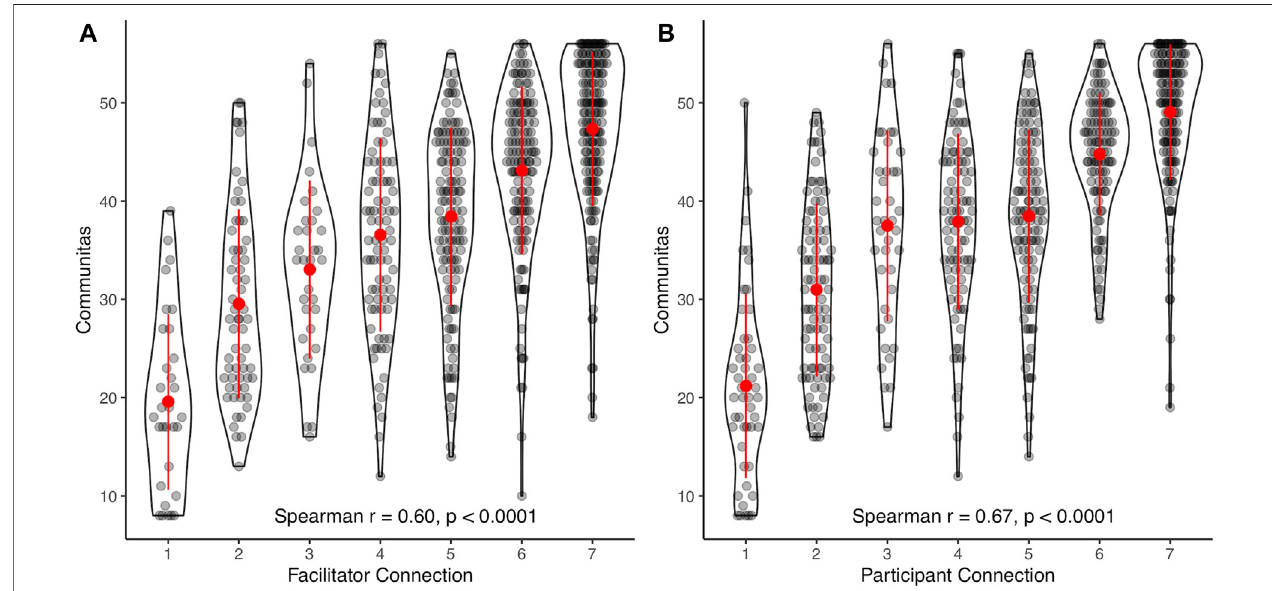
FIGURE4| Distributionofcommunitas(COMS) scoresacrossLikert-typeresponses onitemsmeasuring feltconnectionwithafacilitator (A) oranotherparticipant (B) present during the psychedelic session.